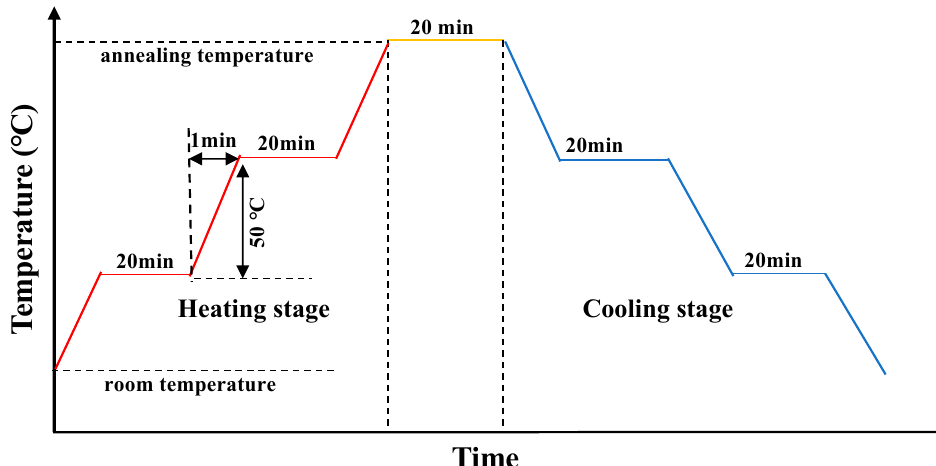
Figure 2. Schematic diagram of the annealing process. (Red curve represents heating stage; blue curve represents cooling stage.)